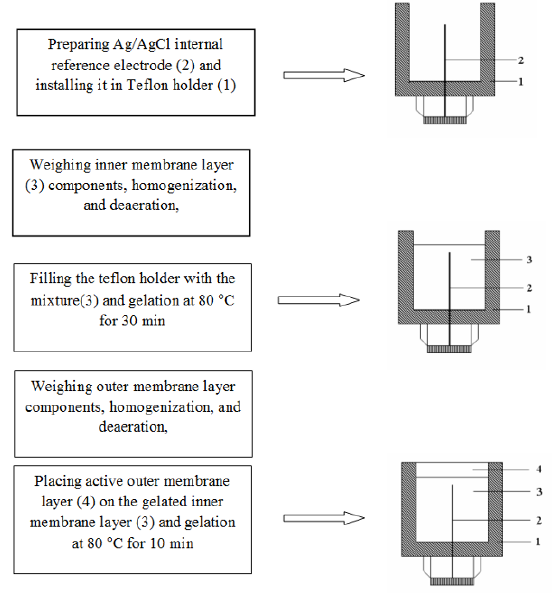
Figure 2. Scheme of electrode